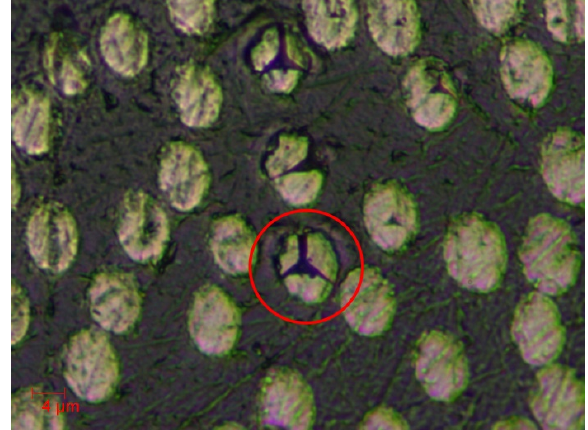
Figure 8. A sample of indent outside the fiber cut section. Note: This is not a pure longitudinal cut, but a diagonal cut.